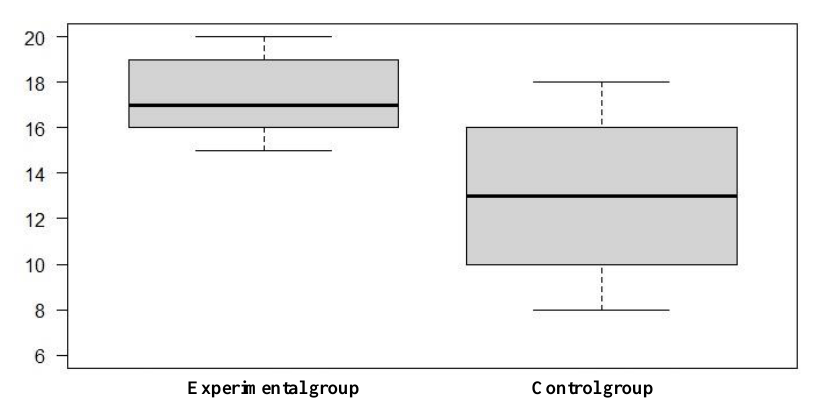
Figure 6. Hypothesis 3 – Appraisal (boxplot)